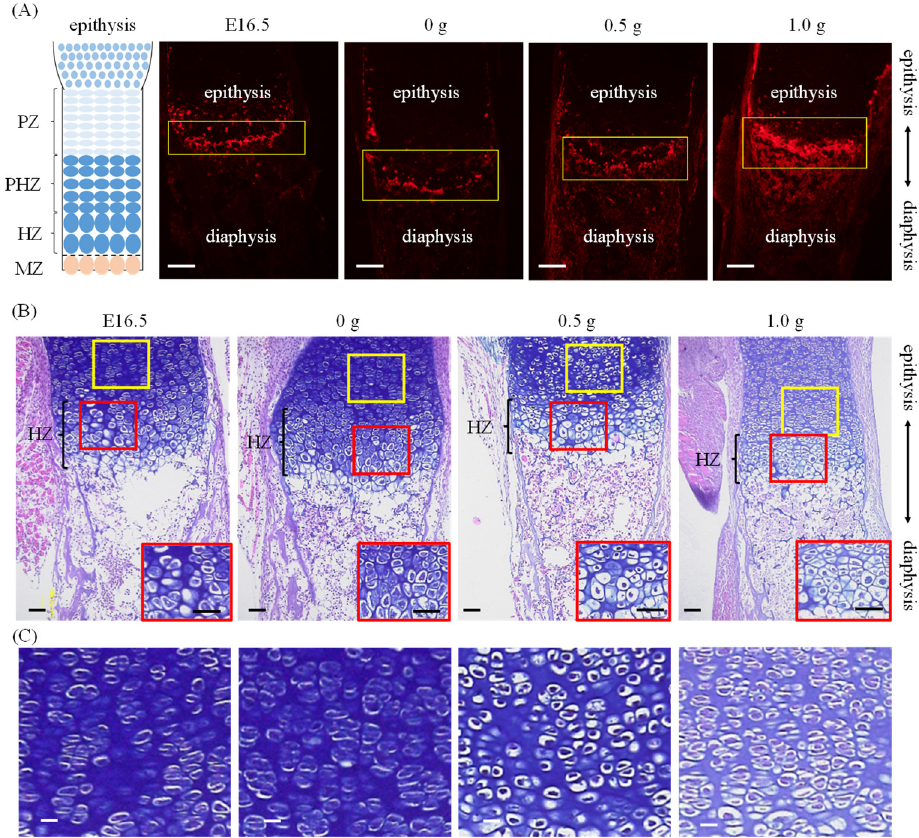
Figure 2. Immunofluorescence and histological images: ( A ) Schematic illustration of growth plate structure and immunohistochemical images of the metaphyseal of femurs. The boxed regions indicate hypertrophic zones or mineralized areas. Red: osteopontin, Scale bars: 100 µm, PZ: Proliferative zone, PHZ: Pre-hypertrophic zone, HZ: Hypertrophic zone, MZ: Mineralized zone. ( B ) Histological images stained with Alcian blue and HE around the metaphyseal of femurs. The insets show the magnified HZs of each femur (Red rectangular area). Scale bars: 50 mm. ( C ) Magnified images of the yellow boxed areas on the upper side are shown.